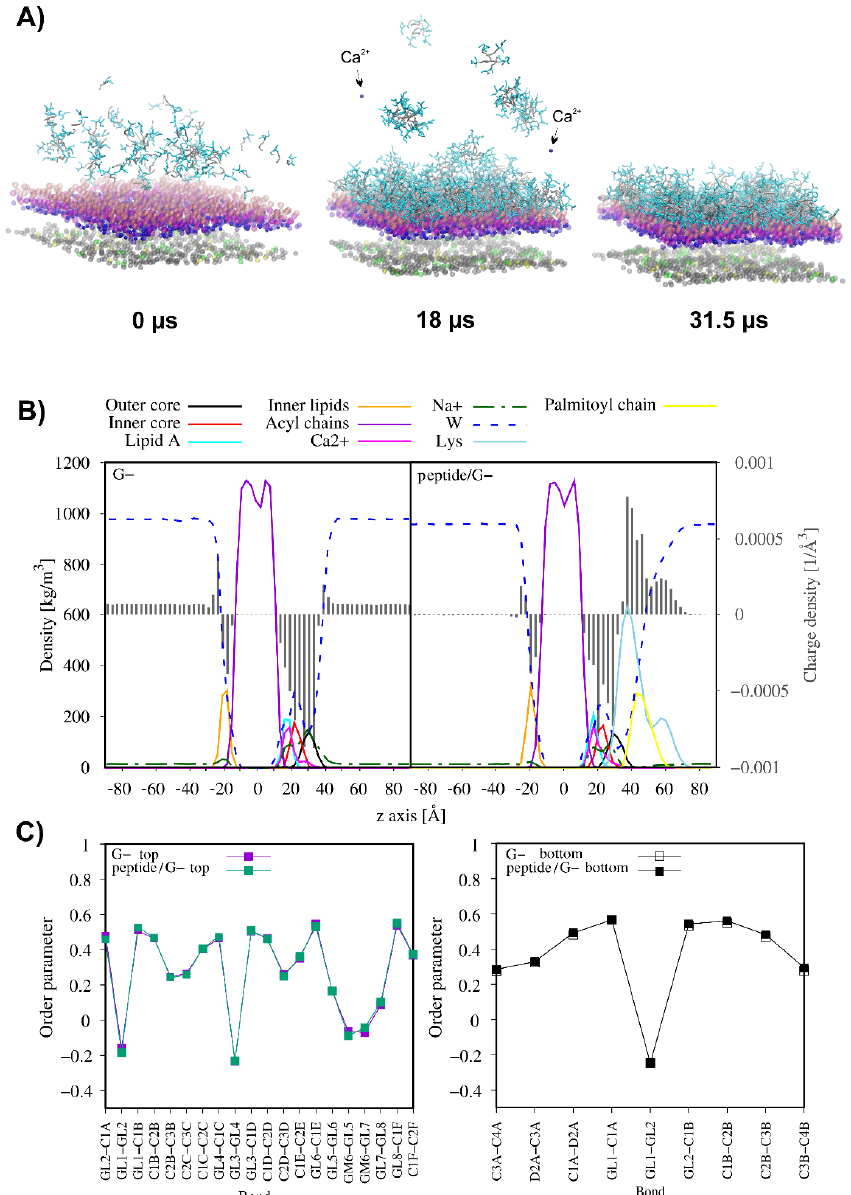
Figure 8. Representative snapshots from the Ra mutant rough chemotype lipopolysaccharide RaLPS/POPE/POPG/CDL2 binding CG MD simulations for C 16 -KKKK-NH 2 . For clarity, only negatively charged beads of the membrane have been displayed. Phosphate groups of the outer oligosaccharide core and Lipid A of RaLPS are in pink and in violet, respectively. The acid groups within the inner oligosaccharide domain of RaLPS are in magenta. Phosphate groups of the inner POPE, POPG, and CDL2 are in gray, yellow and green, respectively. Palmitoyl tails are in gray, while lysine residues are in cyan. The arrows indicate Ca 2+ ions released from the Lipid A part of RaLPS during simulations ( A ). Partial density and charge density profiles averaged over the last 100 ns of CG MD simulations ( B ) and comparison of the lipid acyl chain order parameters of the RaLPS and POPE and POPG in the systems in the absence of the lipopeptide and presence of the lipopeptide ( C ). As just mentioned, C 16 -KKKK-NH 2 was fully transferred into the POPG:POPE mem- brane. This phenomenon drastically reduced the average area per lipid (APL) in the outer leaflet and only slightly increased it in the inner leaflet (Table 5). Interestingly, bind- ing of the lipopeptide had no overall effect on the lateral diffusion of the lipids in